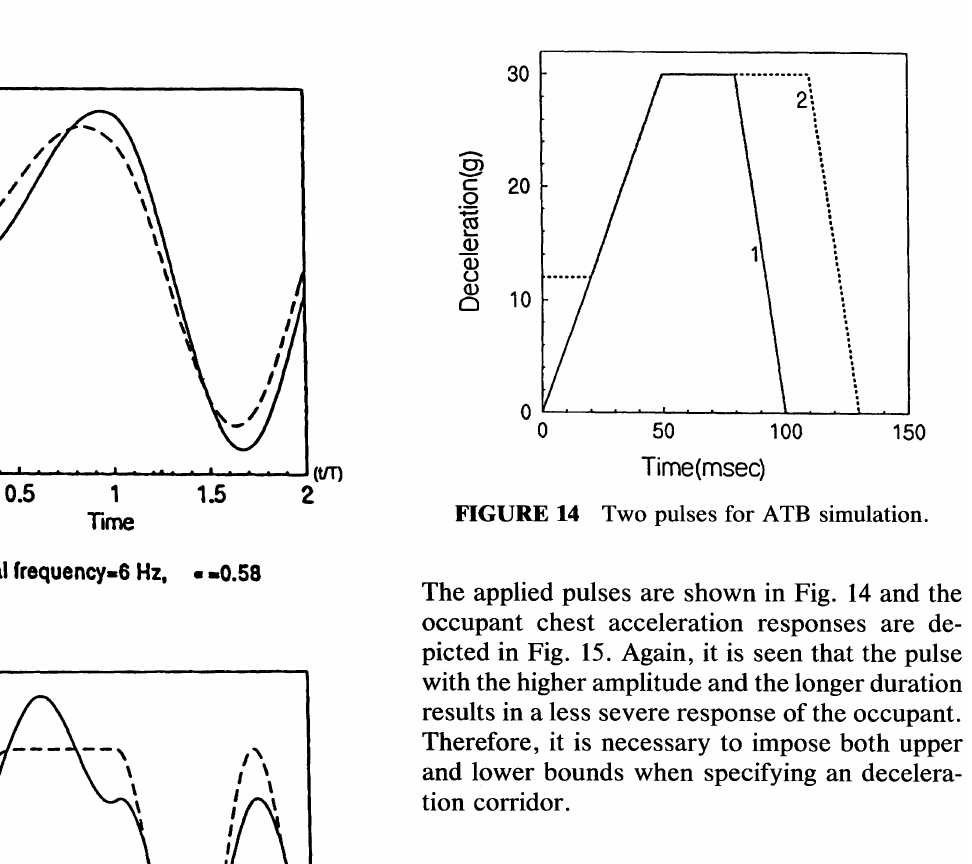
FIGURE 14 Two pulses for ATB